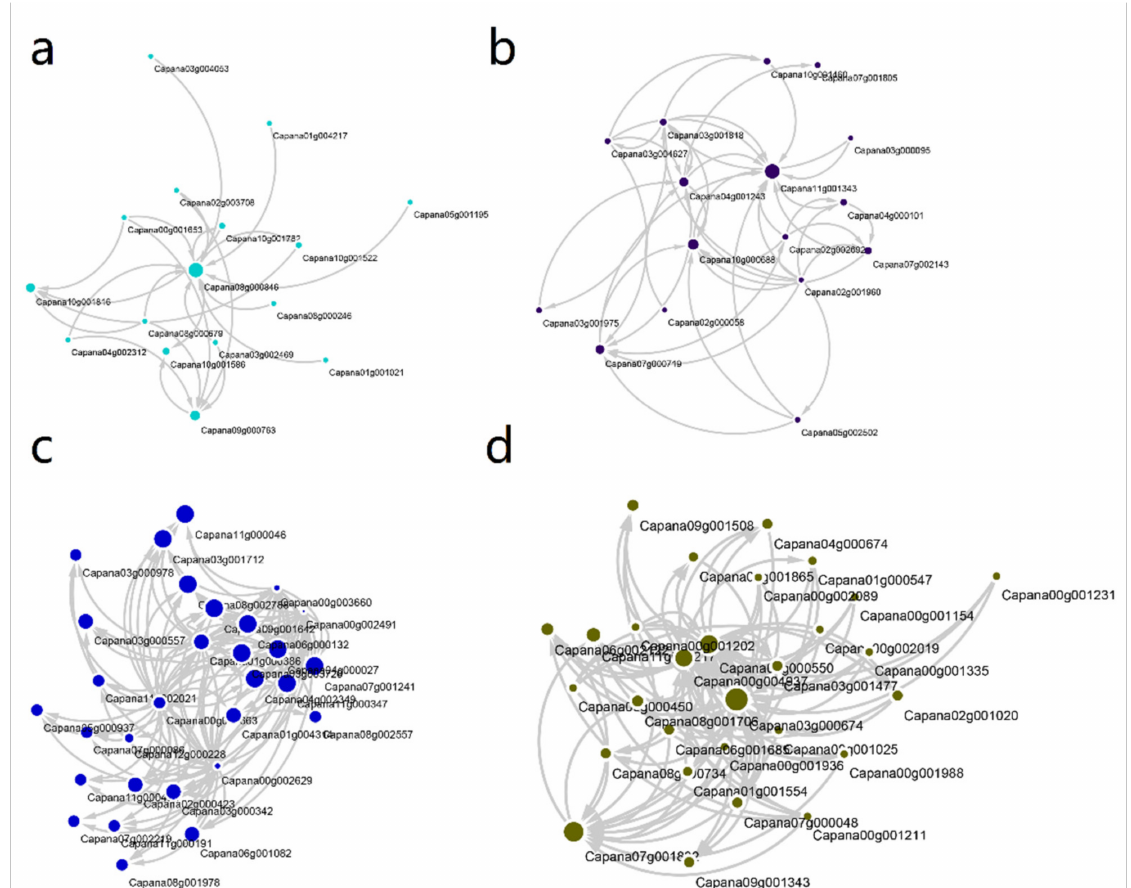
Figure 9. Network analysis of the hub genes in four modules, which had high correlation coefficient values with samples. ( a ) MEturquoise module; ( b ) MEmidnightblue module; ( c ) MEblue module; ( d ) MEtan module. Node size means the indegree of genes.